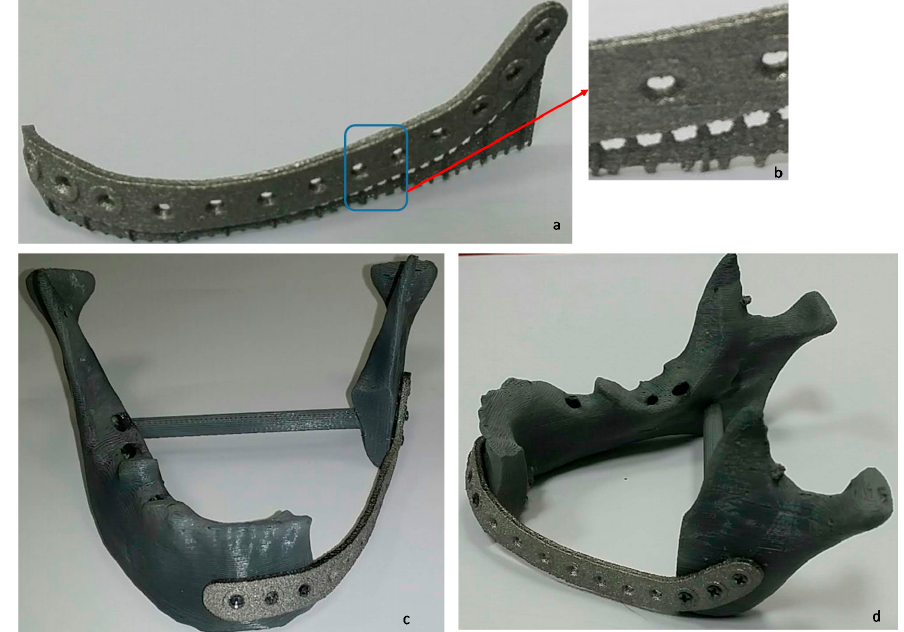
Figure 18. EBM-produced cavity-filled reconstructed titanium implant ( a ) with support structures attached to the teeth ( b ) for easy removal. Front view ( c ) and side view ( d ) of precisely fitted titanium implant onto the FDM model with bi-cortical screws after support removal.